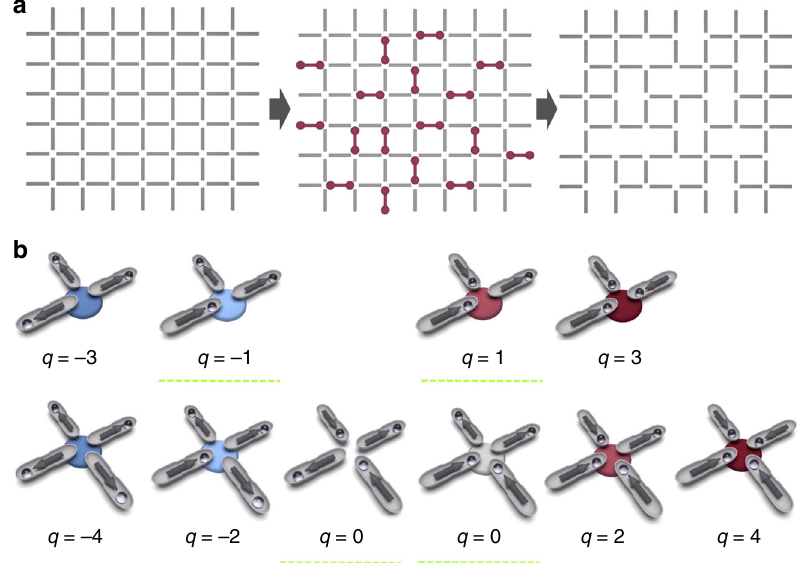
Fig. 2 Schematics of the decimation. a A decimation of the square lattice that creates only z = 3 and z = 4 vertices, but no z = 2 vertices, is equivalent to a partial dimer covering (red dumbbells) of the edges. b Colloid con fi gurations for vertices of coordination z = 4,3, in order of increasing topological charge and thus energy. The ice rule vertices have minimal absolute charge, which is q = ±1 for z = 3 vertices and q = 0 for z = 4 vertices (dashed green underline), and yet, unlike in magnetic spin ice, their energy is not the lowest. Red (blue) disks denote positive (negative) charges. A gray disk on a z = 4 vertex indicates a zero charge excitation corresponding to a biased ice rule vertex. The vertex without a disk represents the “ ground state ” of the square ice. Arrows aligned along the groove and pointing toward the colloids represent the analogy with a spin ice system